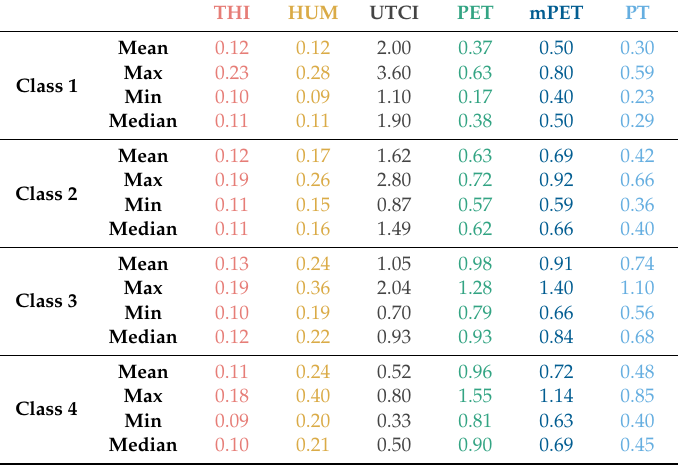
Table 8. Descriptive statistics of the indices’ sensitivity to Wind Speed (WS) under different Air Temperature (T a ) conditions.